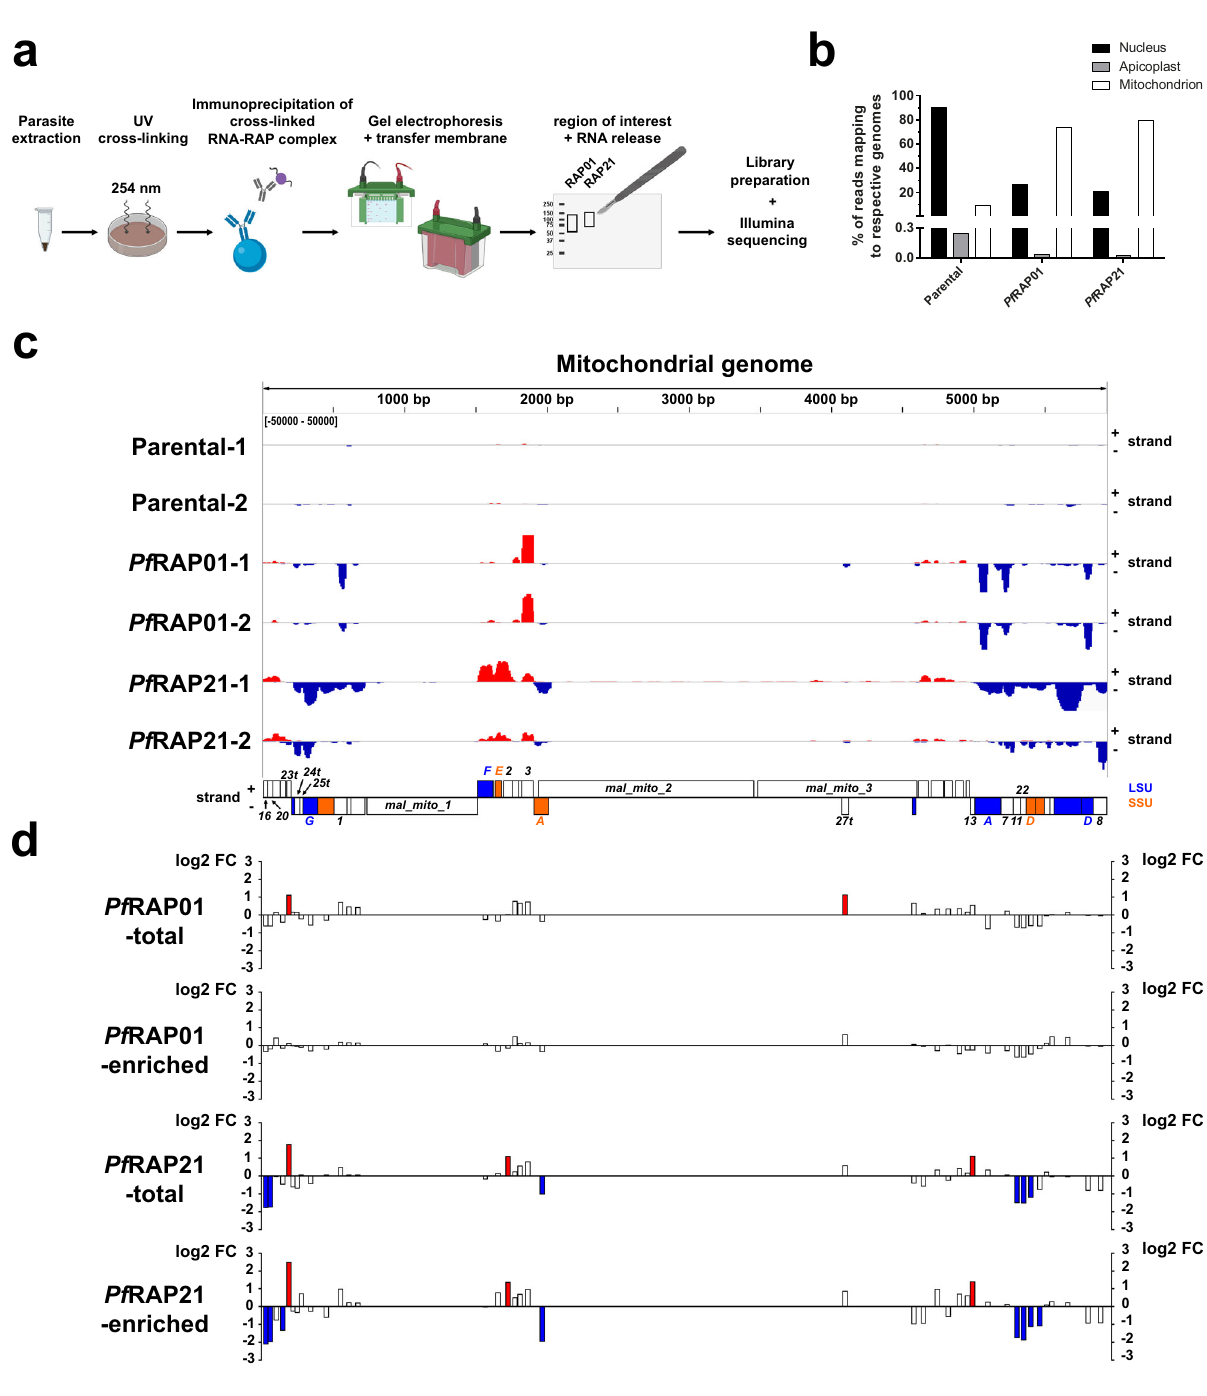
Fig. 6 Pf RAP01 and Pf RAP21 participate in mitoribosome regulation. a The schematic illustrates the key steps of the eCLIP-seq protocol. Created with BioRender.com. b Distribution of the reads to the nuclear and mitochondrial genome. c Read density tracks along the mitochondrial genome for parental, Pf RAP01, and Pf RAP21 samples ( n = 2). SSU = small subunit (orange), LSU = large subunit (blue). d Log2 FC values determined for mitochondrial rRNAs from total and enriched RNA of Pf RAP01 and Pf RAP21 lines. rRNAs identi fi ed as differentially up-regulated and down-regulated (log2 FC > 1 or <1) are respectively indicated in red and